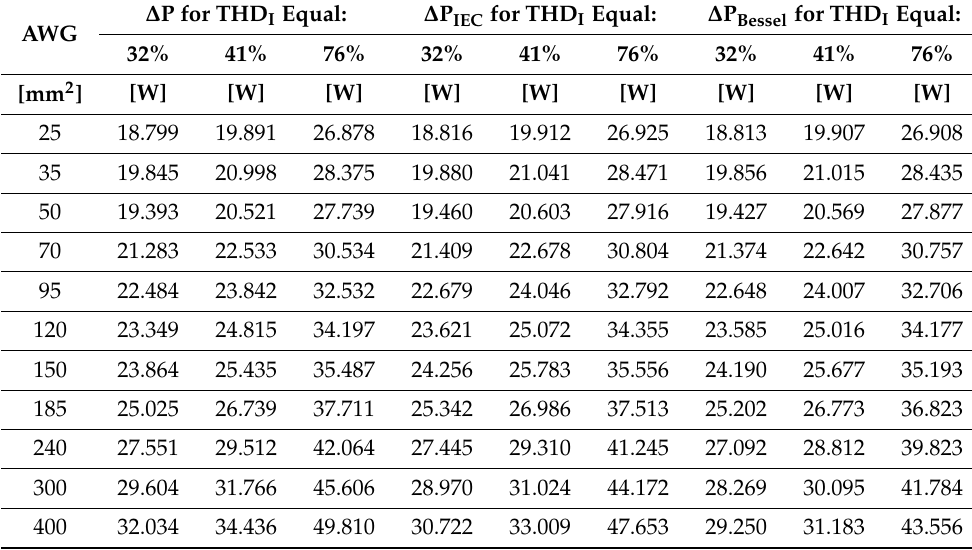
Table 3. The cable power losses for the 75% rated cable current. ∆ P for THD I Equal: AWG